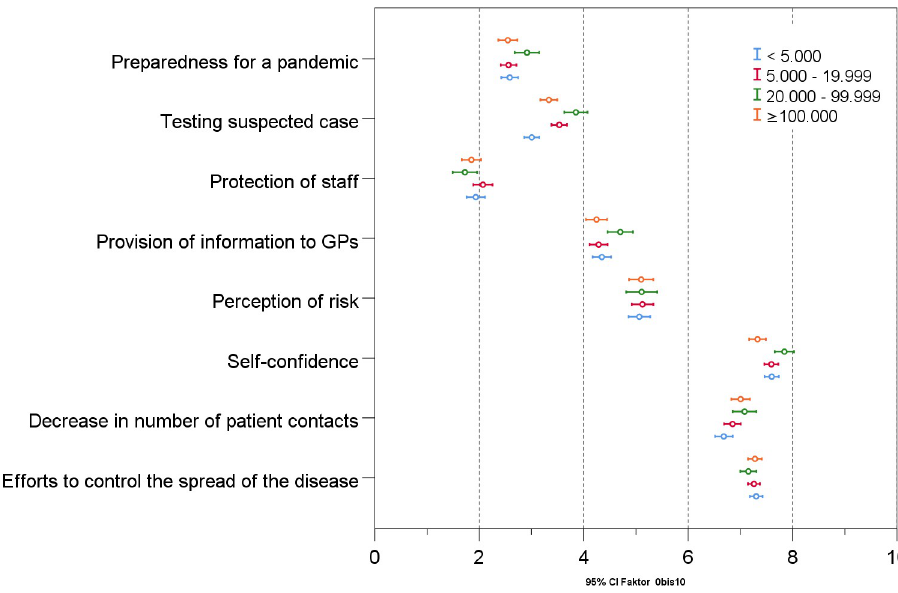
Fig 2. Differences in the evaluation of the pandemic of GPs with practices in cities of different